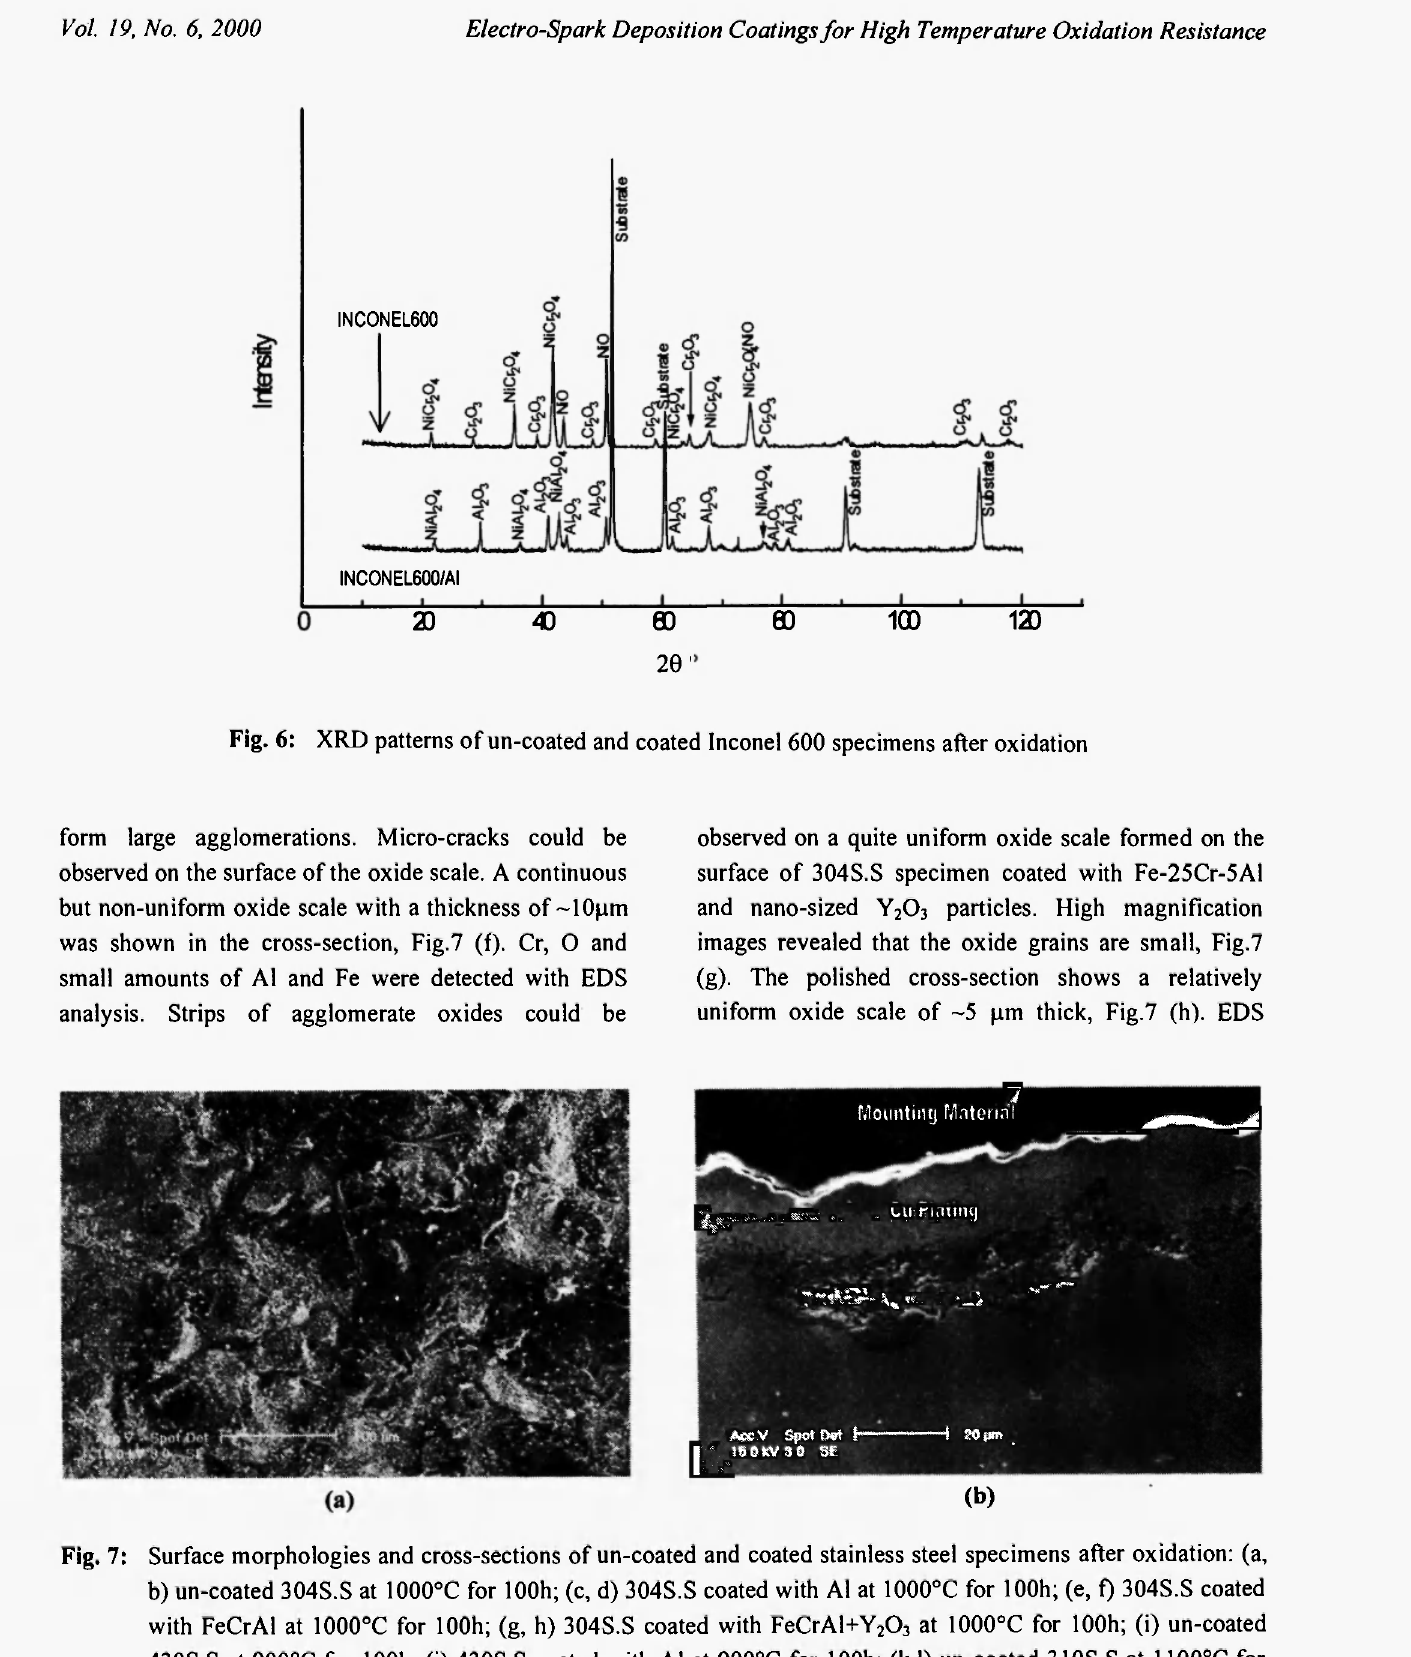
Fig. 7: Surface morphologies and cross-sections of un-coated and coated stainless steel specimens after oxidation: (a, b) un-coated 304S.S at 1000°C for 100h; (c, d) 304S.S coated with Al at 1000°C for 100h; (e, f) 304S.S coated with FeCrAl at 1000°C for 100h; (g, h) 304S.S coated with FeCrAl+Y 2 0 3 at 1000°C for 100h; (i) un-coated 430S.S at 900°C for 100h; (j) 430S.S coated with Al at 900°C for 100h; (k,l) un-coated 310S.S at 1100°C for 100h; and (m) 310S.S coated with FeCrAl + Y 2 0 3 at 1100°C for